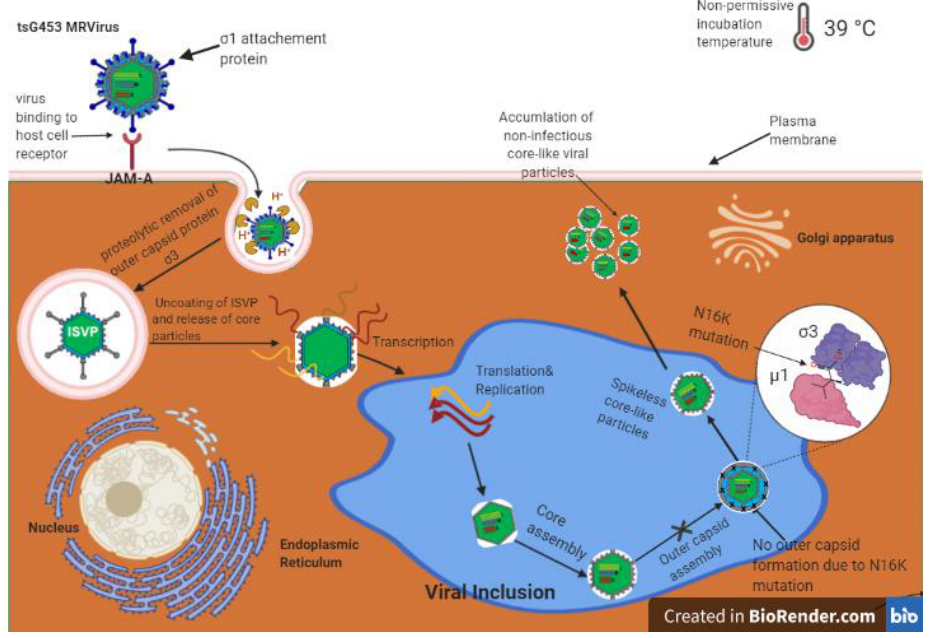
Figure 6. Model for reovirus tsG453 mutant capsid assembly. Reovirus binds to the receptor junction adhesion molecule A (JAM-A; top left), undergoes internalization, and outer-capsid proteins are removed to yield transcriptionally active core particles (center). Viral mRNAs are translated to produce viral proteins and also serve as templates for replication of progeny (−)-sense RNA. Viral proteins encapsidate viral RNA to produce progeny particles in viral inclusions (blue area in center). At the non-permissive temperature of 39 °C, progeny core-like particles are produced. However, the σ 3-N16K mutation prevents σ 3 from forming complexes with outer-capsid protein µ 1. Therefore, core-like particles accumulate in cells, and viral replication is inhibited.